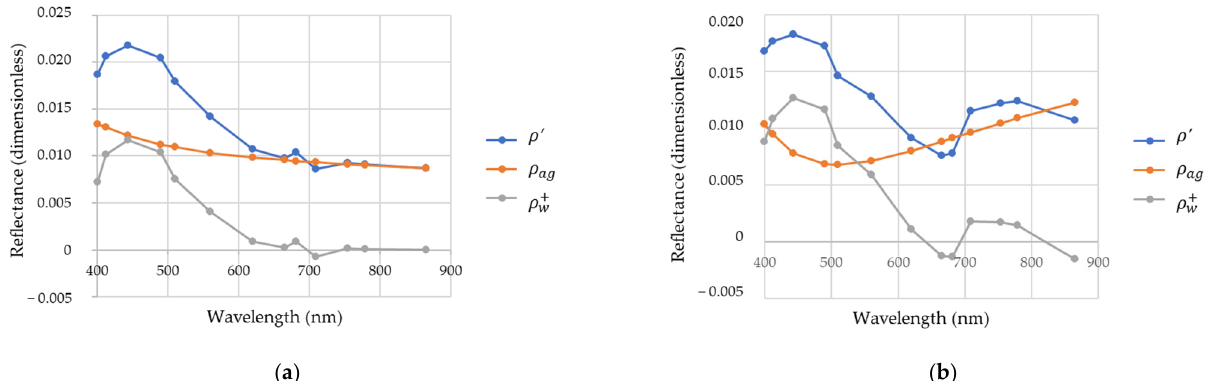
Figure 4. Reflectance corrected for Rayleigh molecular scattering ( 𝜌′ ), reflectance of aerosol and sunglint ( ρ ag ) and above water reflectance: ( a ) for a Sargassum -free area; ( b ) for a Sargassum -dominated area.